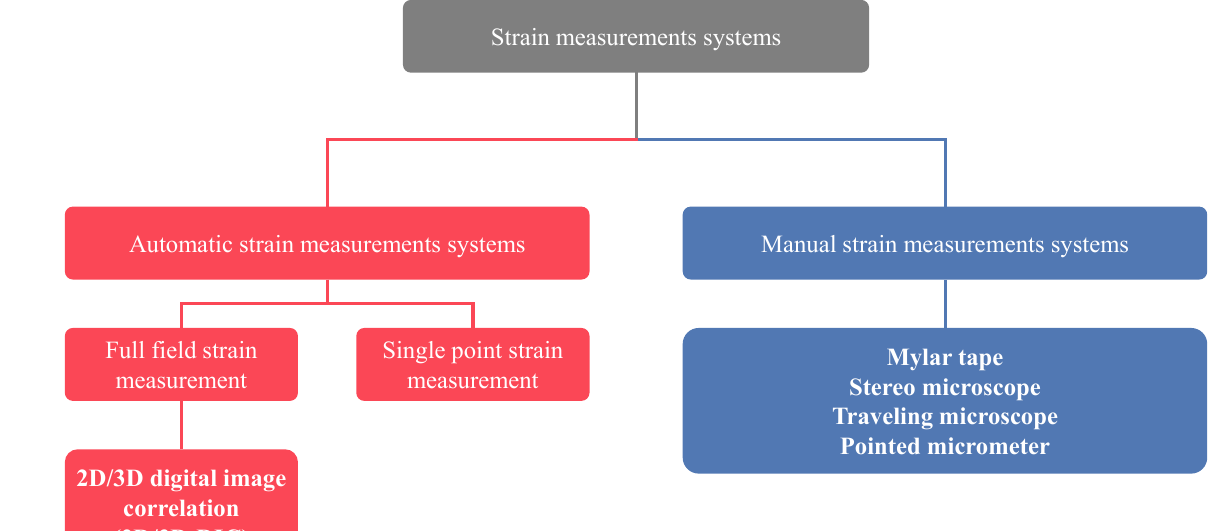
Figure 29. Classification of automatic strain measurement system.